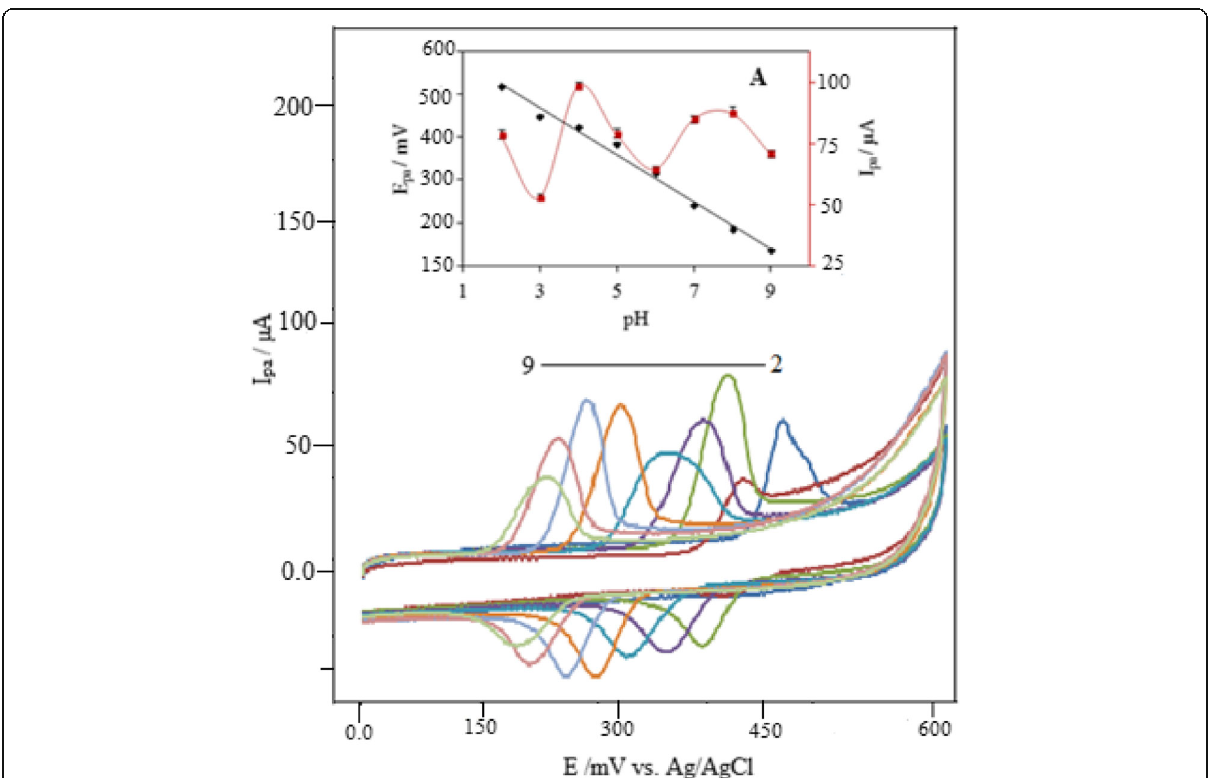
Fig. 7 CVs of Bi 2 O 3 / MWNT/GCE in 0.1 mM paracetamol at different pH values (0.1 M PBS). Scan rate 100 mV s − 1 . Error bar = ± S.D. and n =